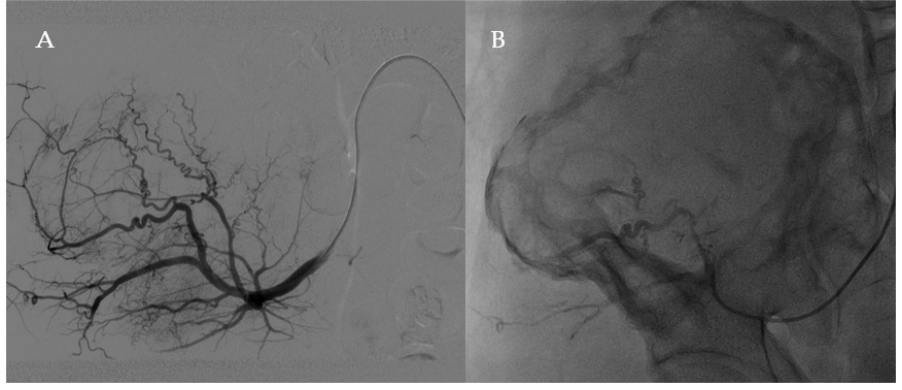
Figure 2. Angiography of arterial embolisations, before ( A ) and after ( B ) the procedure.